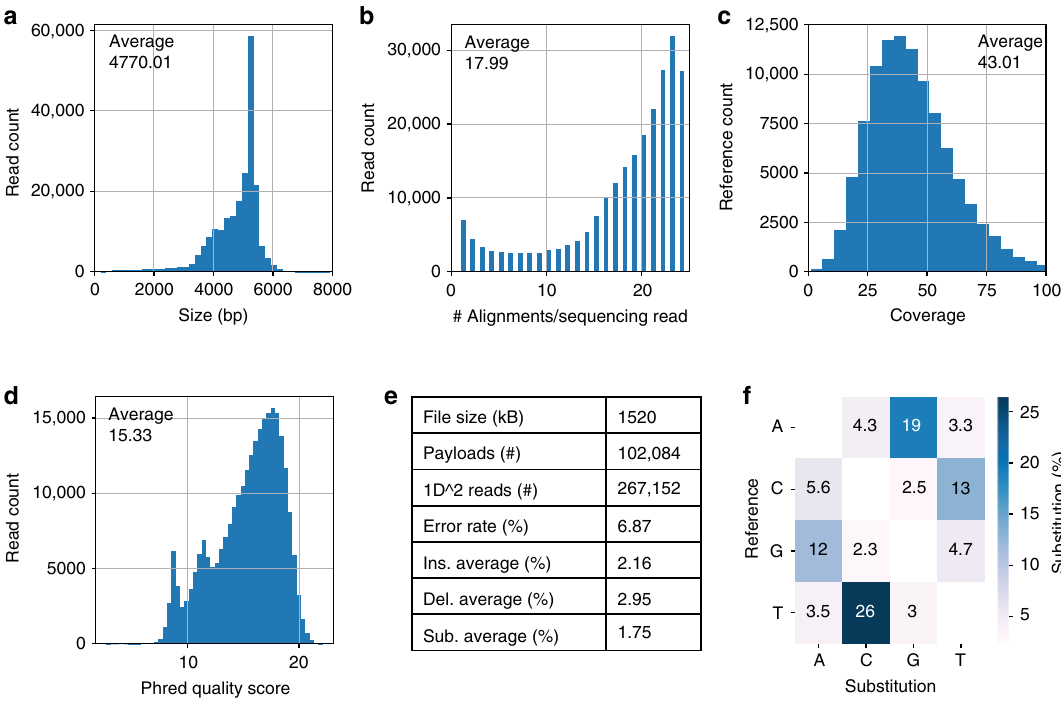
Fig. 4 Nanopore sequencing analysis for 1.5 MB Apollo fi le. Two MinION fl owcells generated 267,152 1D 2 reads of the 24-fragment Gibson Assembly